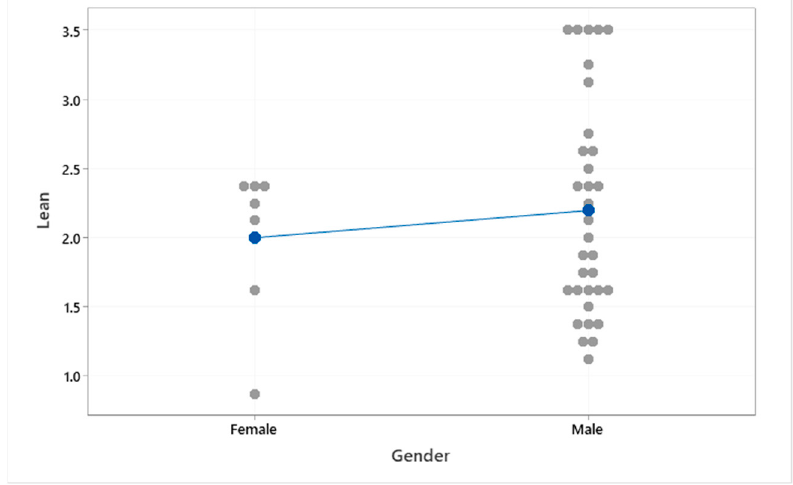
Figure 15. Individual value plot of agile vs. gender . Figure 16 indicates that the responses of participants of most respondents are almost the same regarding agile methodology; however, the answers have changed in the age group of 61 to 70.